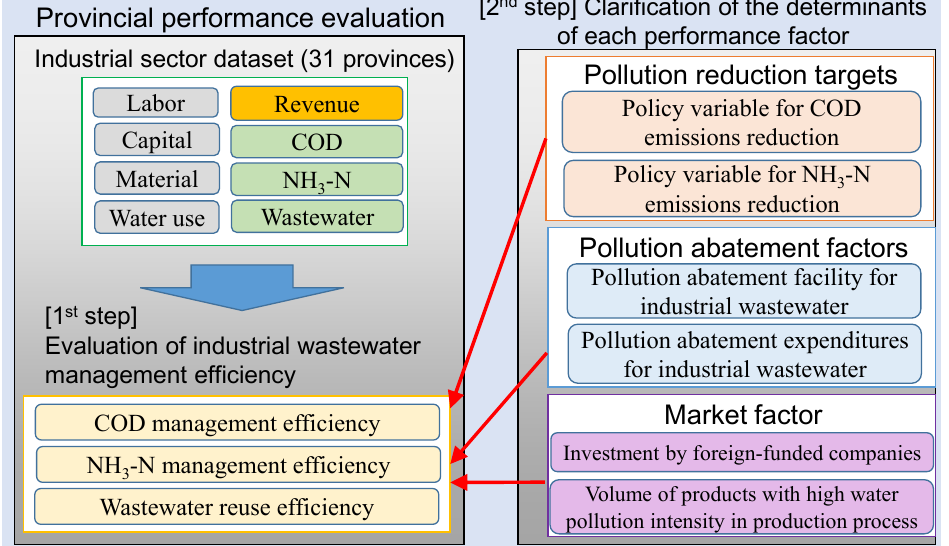
Figure 3. Research framework of this study.